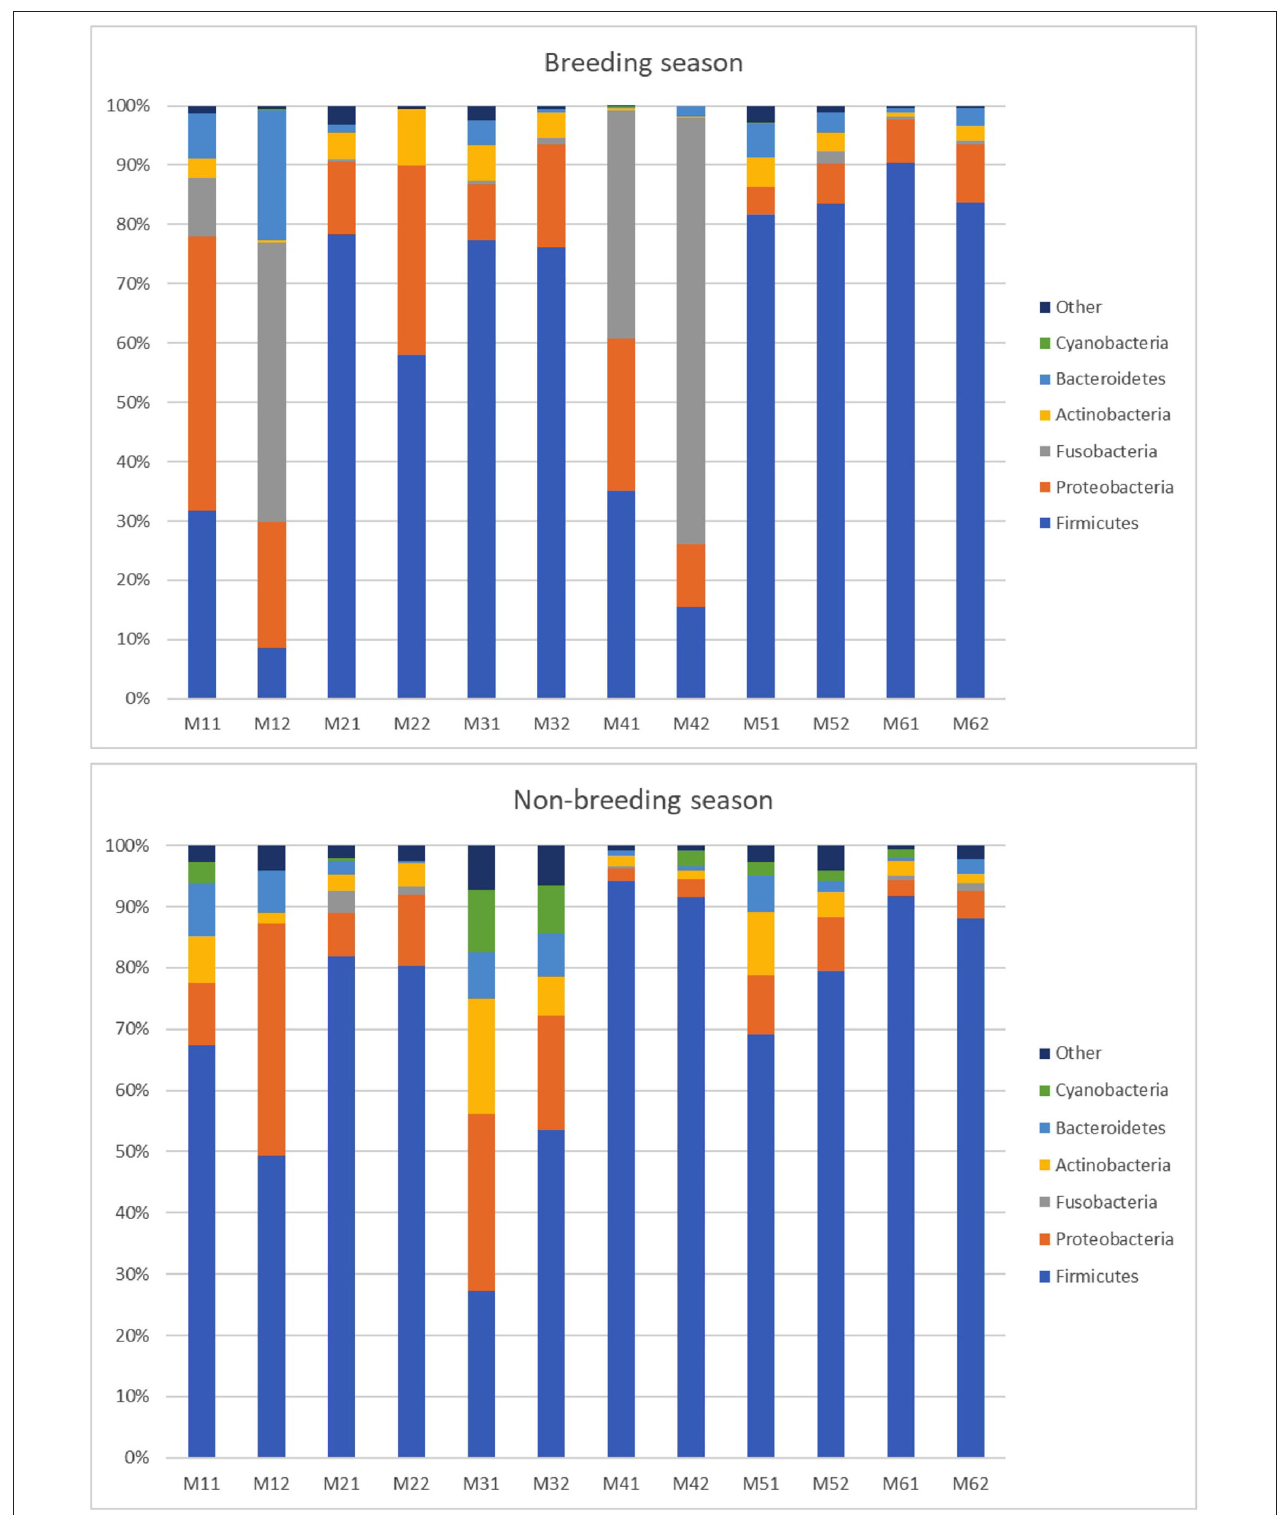
FIGURE 3 | Relative abundance of taxa at the phylum level in the individual goat buck ejaculates collected during the breeding and non-breeding seasons (only the taxa with a mean relative abundance > 1.5% for the breeding or non-breeding seasons are represented). The letters on the x-axis correspond to each individual sample. M11 and M12 are the samples of Male 1; M21 and M22 are the samples of Male 2; M31 and M32 are the samples of Male 3; M41 and M42 are the samples of Male 4; M51 and M52 are the samples of Male 5; and M61 and M62 are the samples of Male 6.